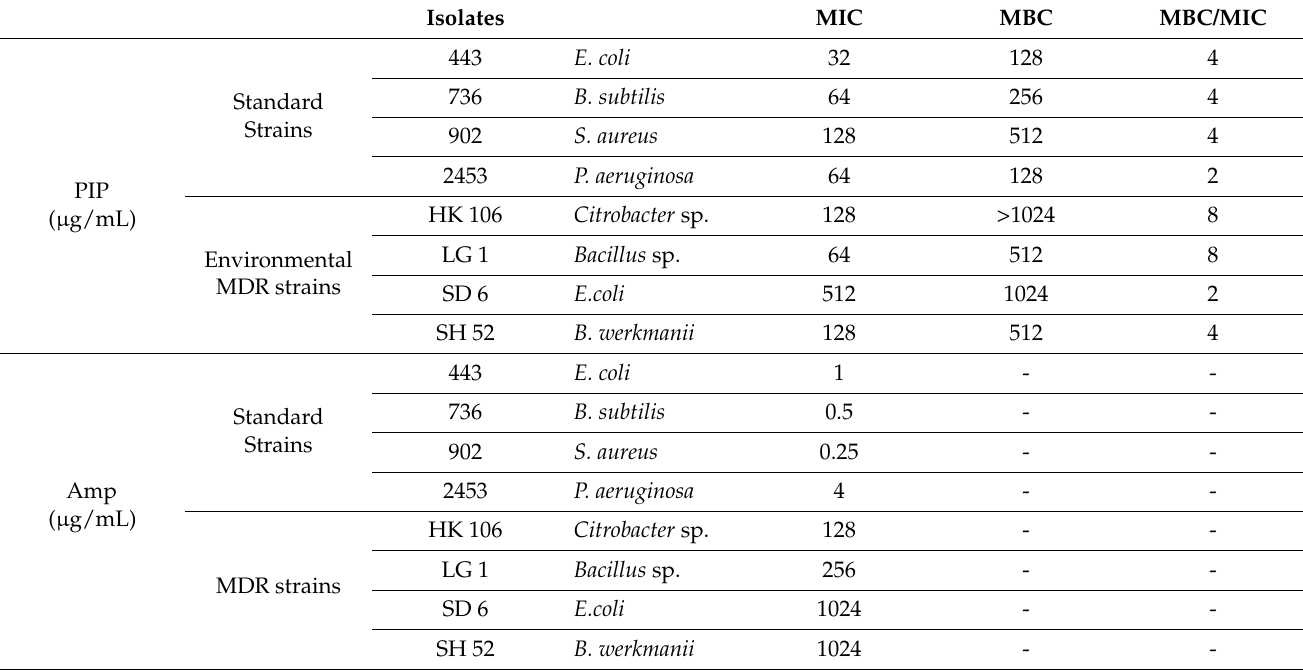
Table 1. MIC and MBC Values ( µ g/mL) of PIP and AMP against bacterial strains.